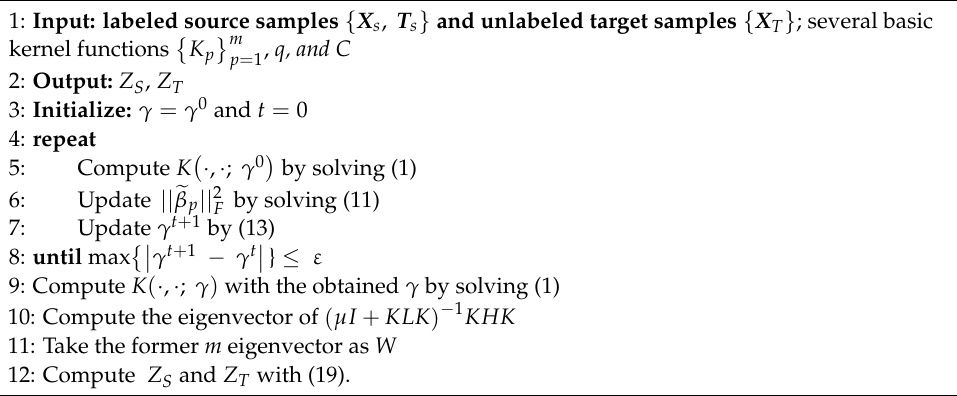
Algorithm 1. Marginal Distribution Adaptation: